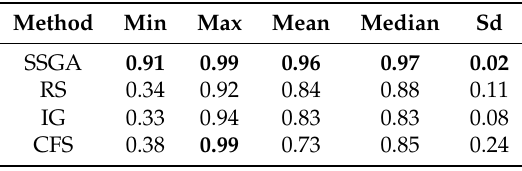
Table 3. Fitness results summary for the feature selection problem.